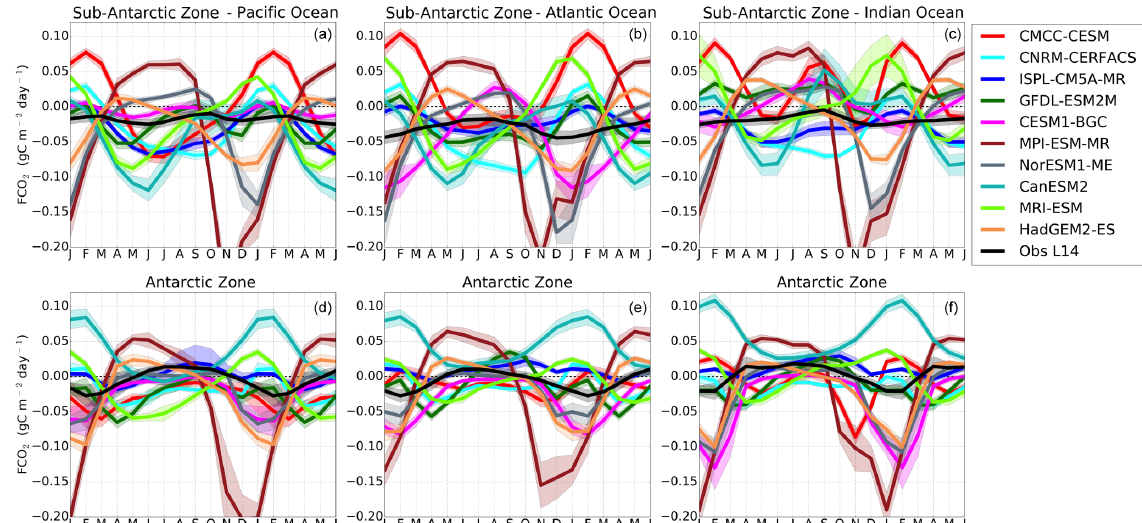
Figure 2. Seasonal cycle of sea–air CO 2 flux ( F CO 2 , in gCm − 2 yr − 1 ) in observations and 10 CMIP5 models in the Sub-Antarctic and Antarctic zones of the Pacific Ocean (first column), Atlantic Ocean (second column) and Indian Ocean (third column). The shaded area shows the temporal standard deviation over the considered period (1995–2005).